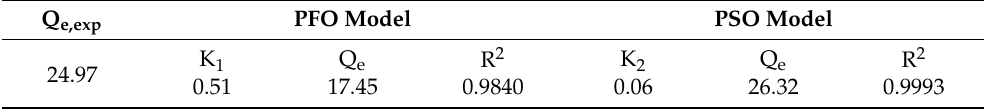
Table 1. Kinetic model parameters for Cd 2+ removal using tobermorite. Q